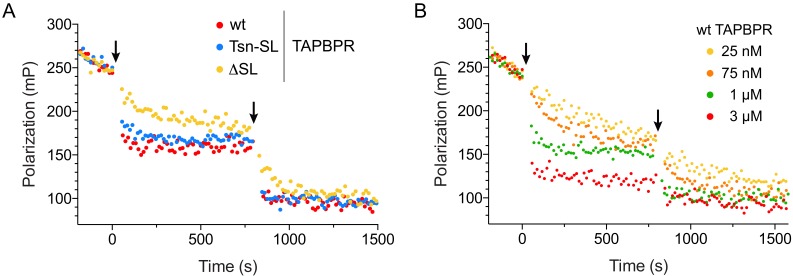
The scoop loop acts as a selectivity filter during peptide editing.(A) Peptide displacement from HLA-A*02:01 (300 nM) loaded with fluorescently-labeled peptide (FLPSDC*FPSF) was monitored by fluorescence polarization after addition of TAPBPR (1 µM, first arrow) and after subsequent addition of a 1000-fold molar excess of unlabeled high-affinity competitor peptide (FLPSDEEPYV, 300 µM, second arrow). (B) Titration of peptide-loaded HLA-A*02:01 (300 nM) with varying concentrations of TAPBPRwt (first arrow) and final addition of a 1000-fold molar excess of unlabeled high-affinity competitor peptide (300 µM, second arrow). The data shown in (A) and (B) are representative of three independent measurements.